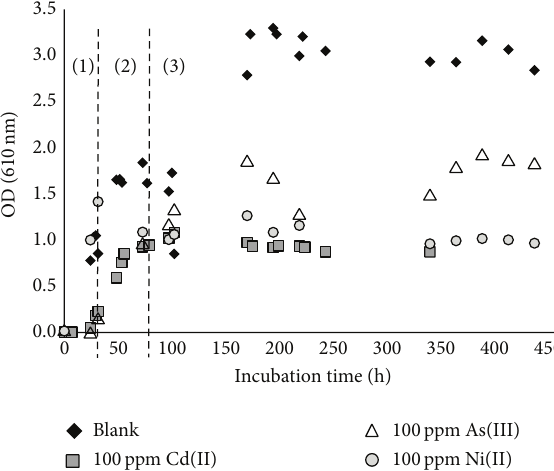
Figure 3: Growth curves of Bacillus mucilaginosus in broth in the presence of 100 ppm Cd(II) (0.9mM), As(III) (1.3 mM), or Ni(II) (1.7 mM) compared to a blank medium without metal addition, determined according to optical density: (1) lag phase, (2) exponen- tial phase, and (3) stationary